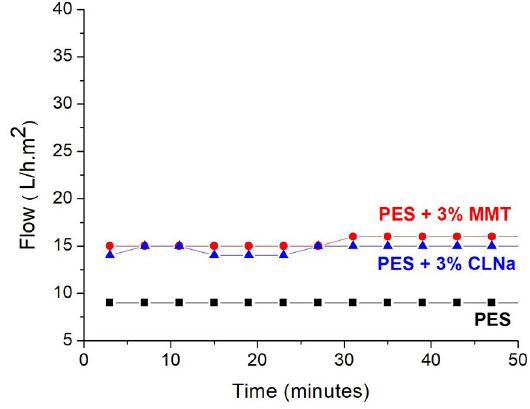
Figure 9 . Flow measures with distilled water for pressure of 1.0 bar. The presence of the solvent together with the amount of 3%